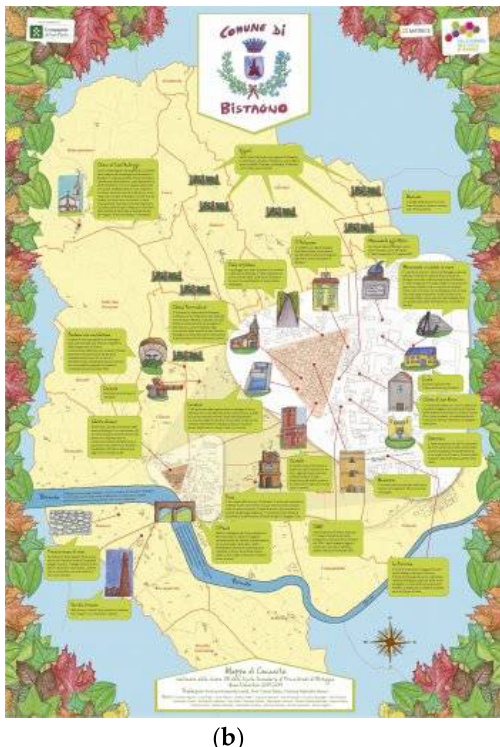
Figure 2. ( a ) Village of Bistagno (Italy): codified image of territory. Image source: Google Map; ( b ) One of Bistagno’s Parish Maps. Image source: